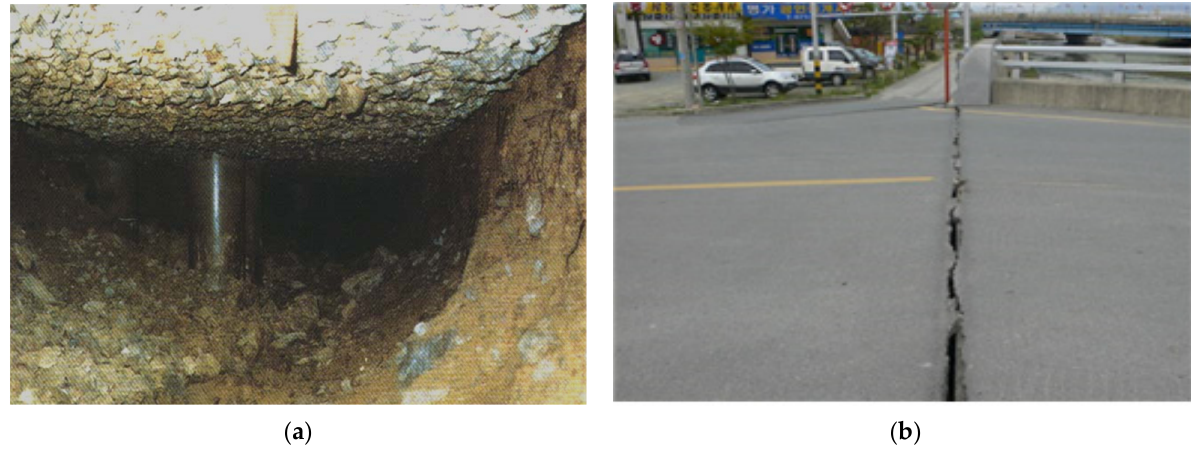
Figure 1. Example of a problem due to the difference in the settlement between a structure supported by a soil foundation and the lateral ground [9]: ( a ) cavity development; ( b ) failure of the approach slab pavement. The most frequently used measure to address these problems is the overlay method.